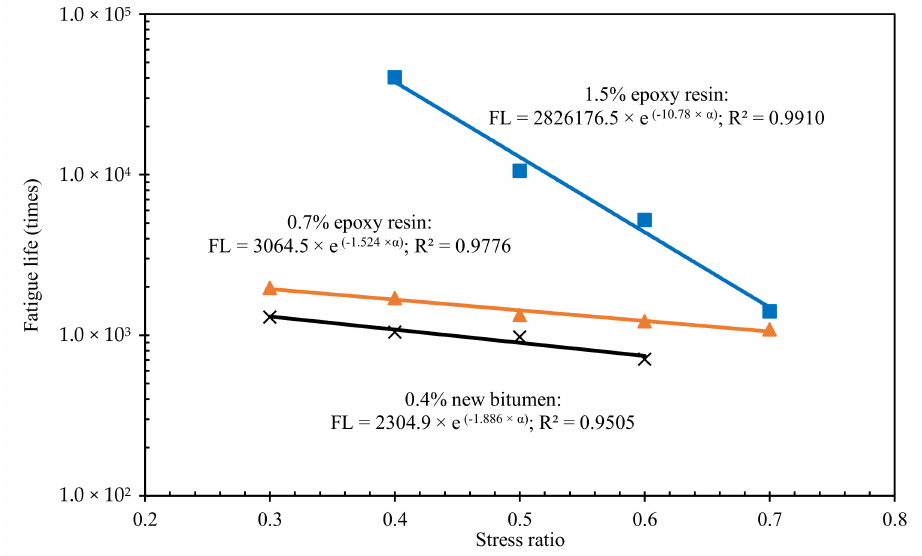
Figure 8. Fatigue life of the BRA-rejuvenated